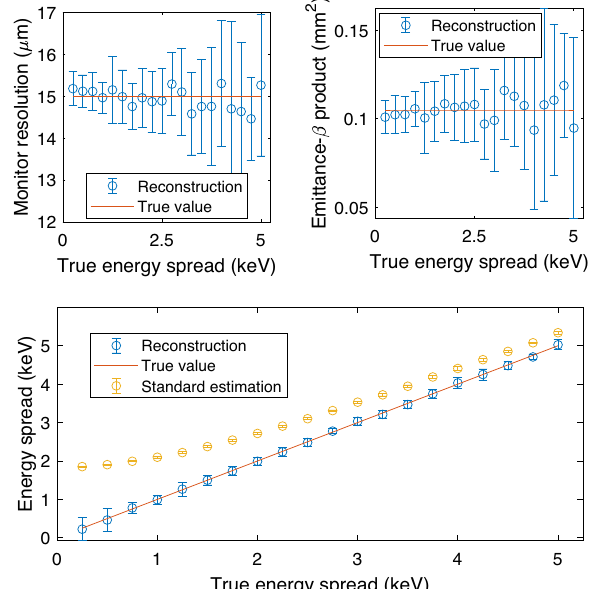
FIG. 2. Calculated performance of the method for the param- eters shown in Table I and energy spread values between 0.25 and 5 keV. We show the true value and reconstruction of the monitor resolution (top left), intrinsic beam size (top right) and energy spread (bottom). The energy spread estimation using the standard approach is also